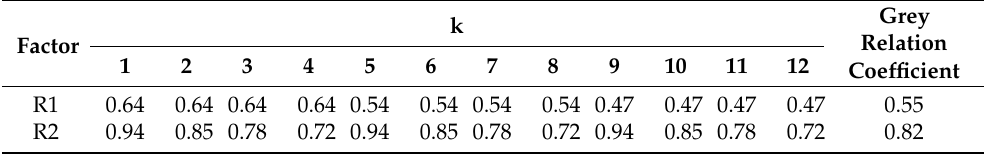
Table 5. The grey correlation coefficients for different contents of